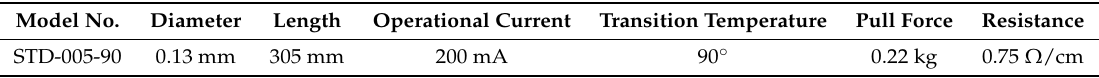
Table 1. Flexinol wire